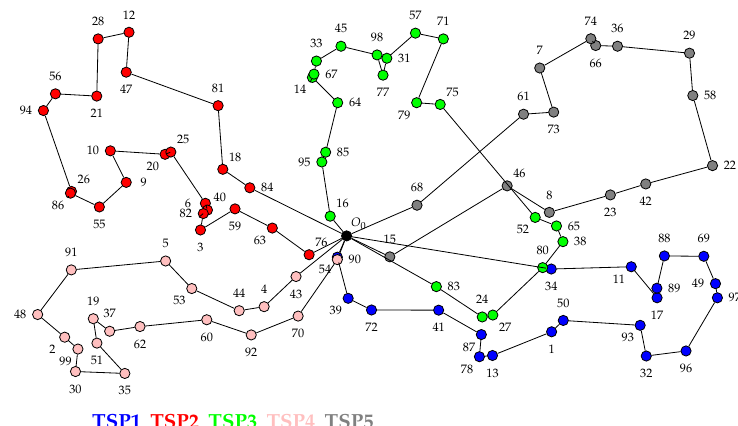
Figure 9. Tours for 5TSP100.